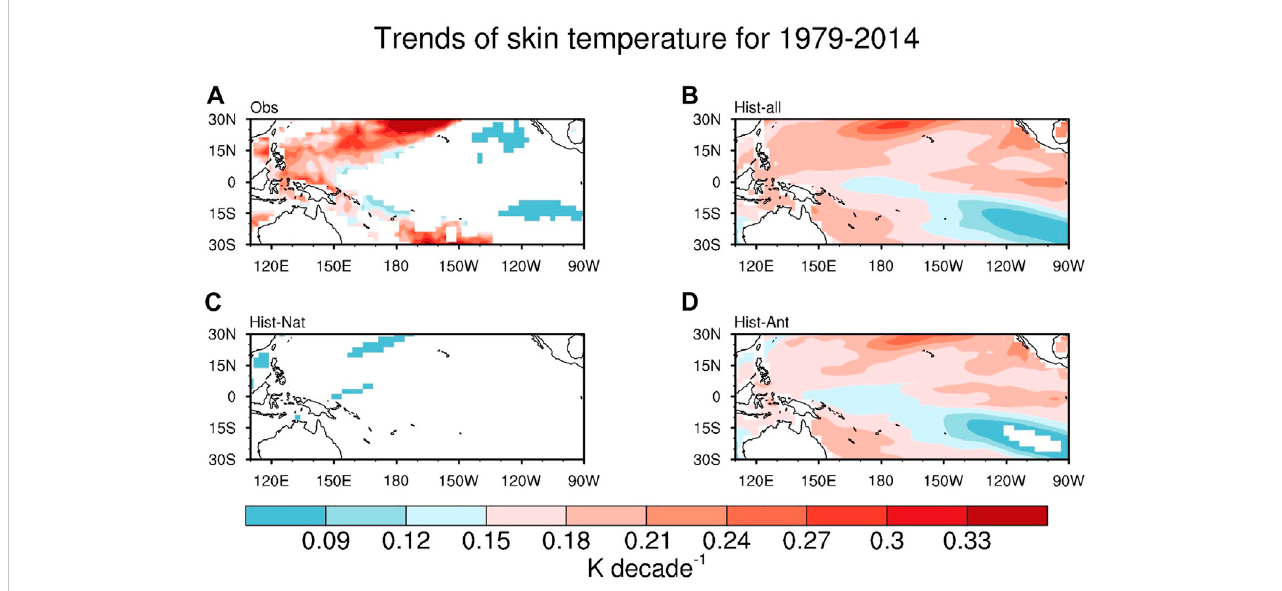
FIGURE 9 Spatialdistributionofwinterskintemperaturetrends(shading,SI=0.03 K decade − 1 )from1979to2014in (A) ERA5, (B) Hist-all, (C) Hist-Nat,and (D) Hist- Ant MME, respectively. Values exceeding the 90% con fi dence levels based on the two-tailed Student ’ s t -test are